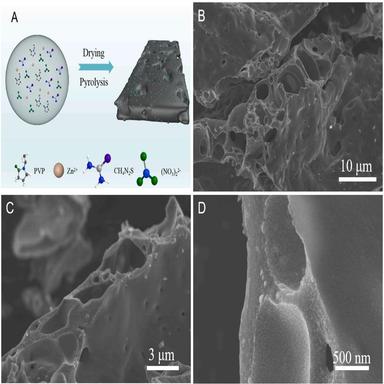
(A) Schematic illustration of the preparation of ZnS/NC composite; (B, C, D) SEM images of ZnS/NC composite.